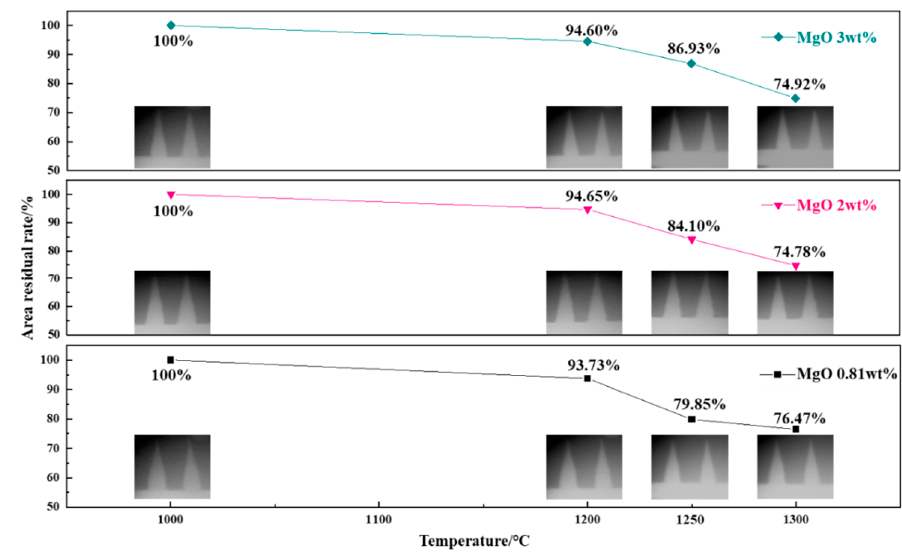
Figure 7. Effect of MgO on standard pyrometric cone area residual rate of deposits.